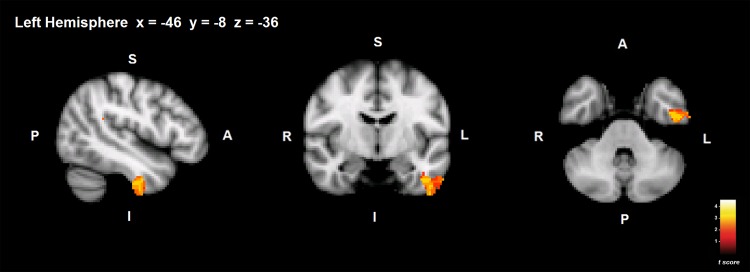
Group differences in GM volume.GM areas showing volume decrease in PD compared to healthy controls are shown in red-yellow. S = superior; I = inferior; A = anterior; P = posterior. Coordinates are shown in MNI space (Montreal Neurological Institute).